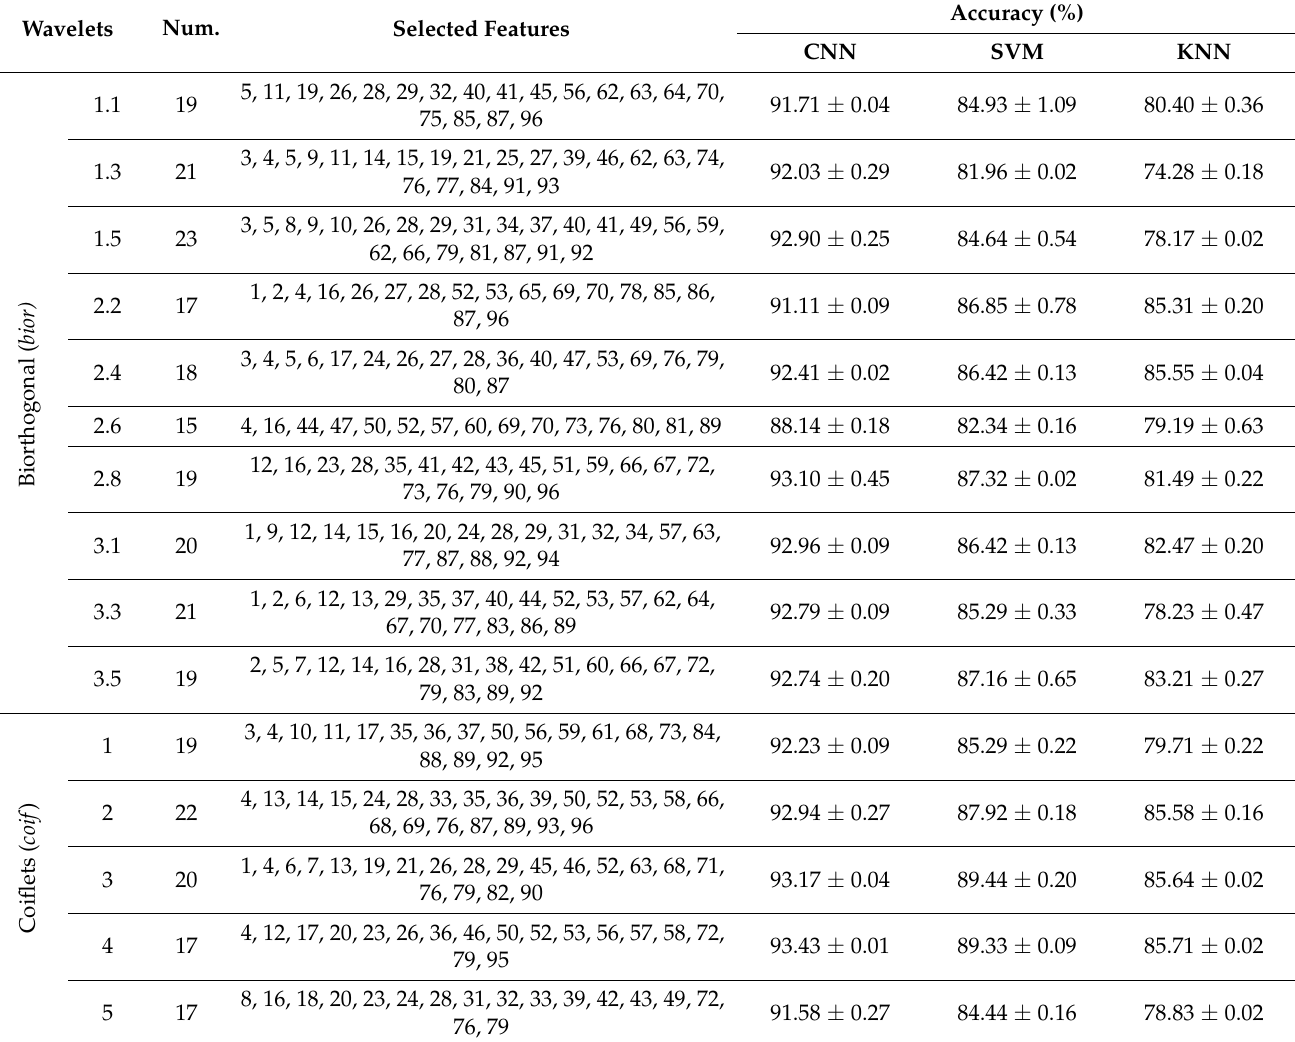
Table 7. The performance of the classifiers for selected features by the PSO-SVM wrapper approach. Wavelets